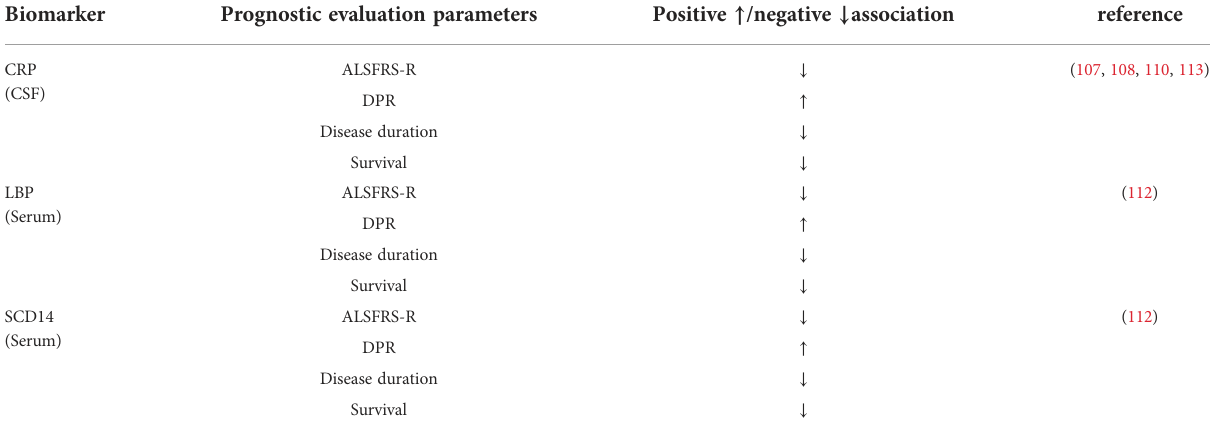
TABLE 3 Association of Acute phase protein and prognostic evaluation parameters in ALS patients.